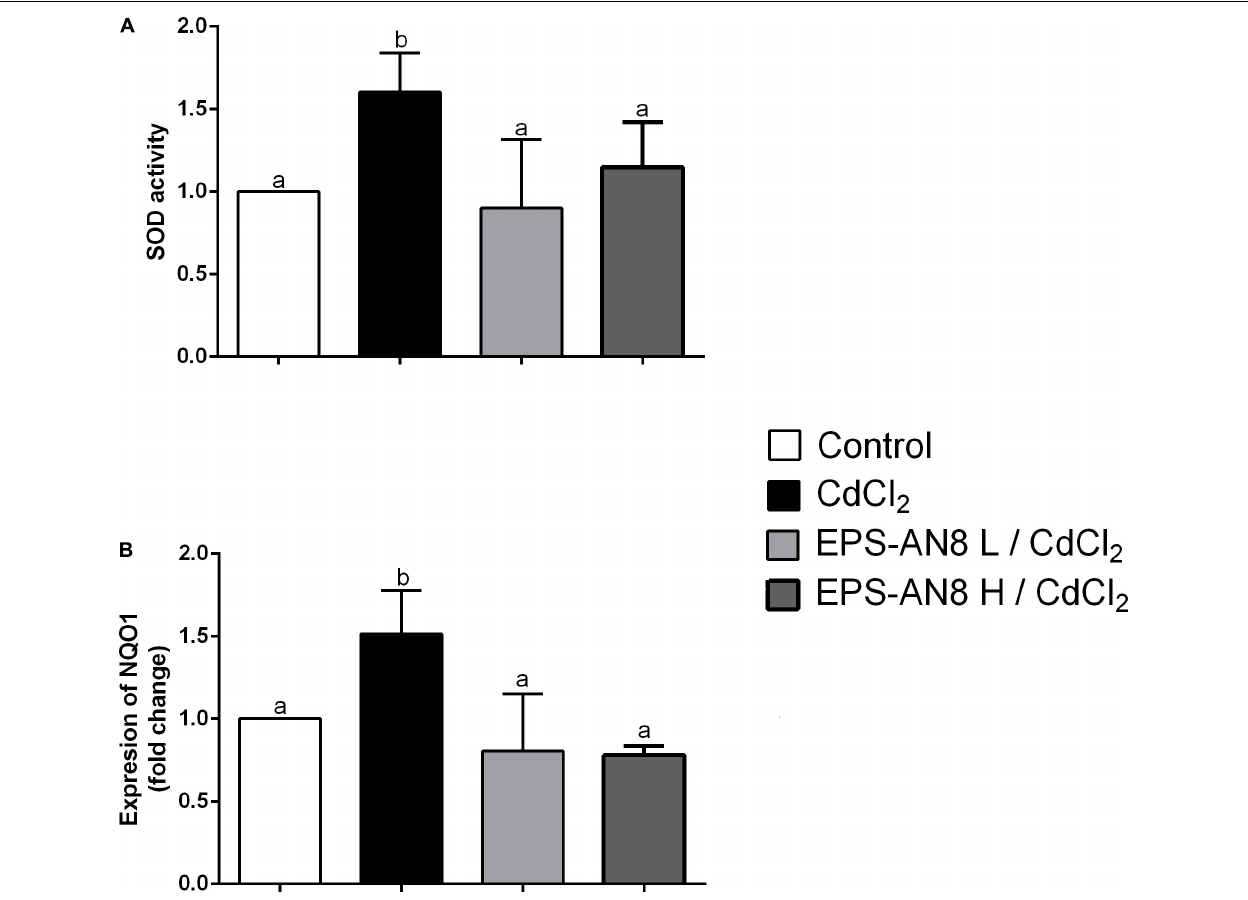
FIGURE 5 | Role of EPS (L and H) in protection of Cd-induced oxidative stress. (A) Effect on SOD activity and (B) mRNA expression of NQO1 . Values that do not share a common letter are significantly ( p < 0.05)